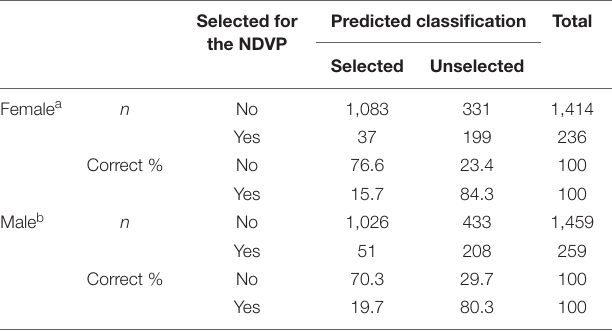
TABLE 5 | Classification of the stepwise discriminant function analysis ( n and